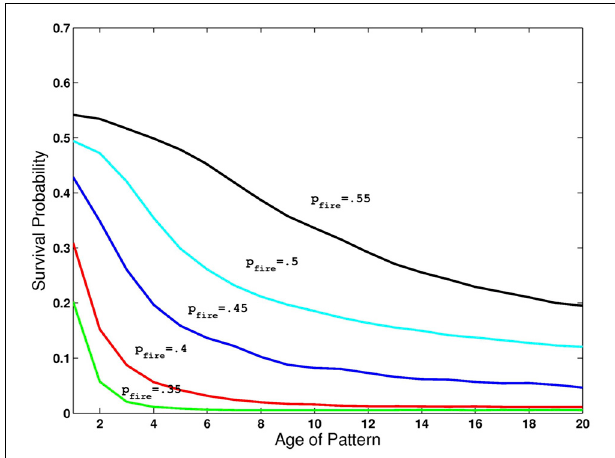
FIGURE 2 | Retention of multiple images in recurrent activity. Probability of image maintaining recurrent activity as a function of its age for different levels of p fire and all other parameters at default levels given in Table 1